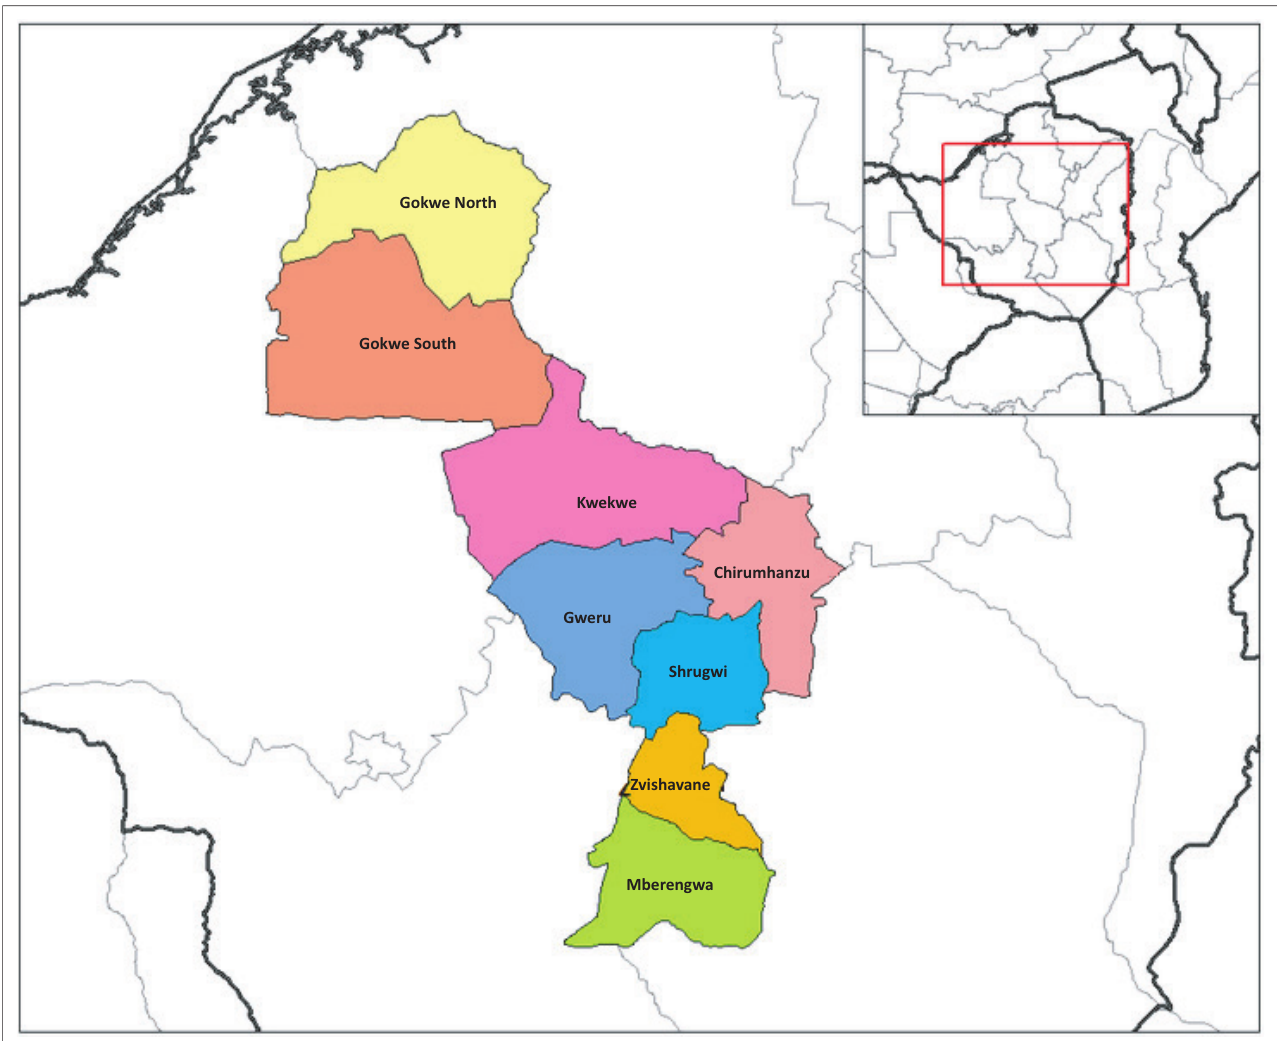
Source : Wikipedia, 2018, Shurugwi District , viewed 10 March 2018, from https://en.wikipedia.org/wiki/Shurugwi_District?oldid=708198202. FIGURE 1: Map of Shurugwi district in the Midlands province.